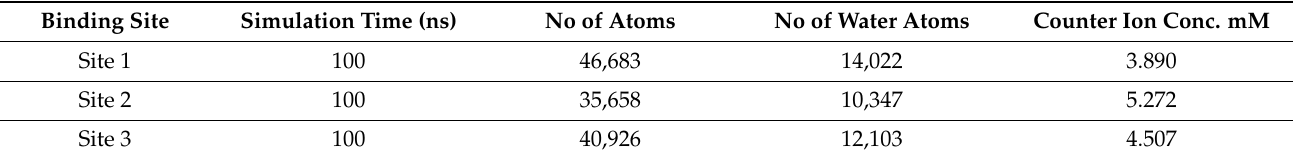
Table 1. System details for MD simulation.